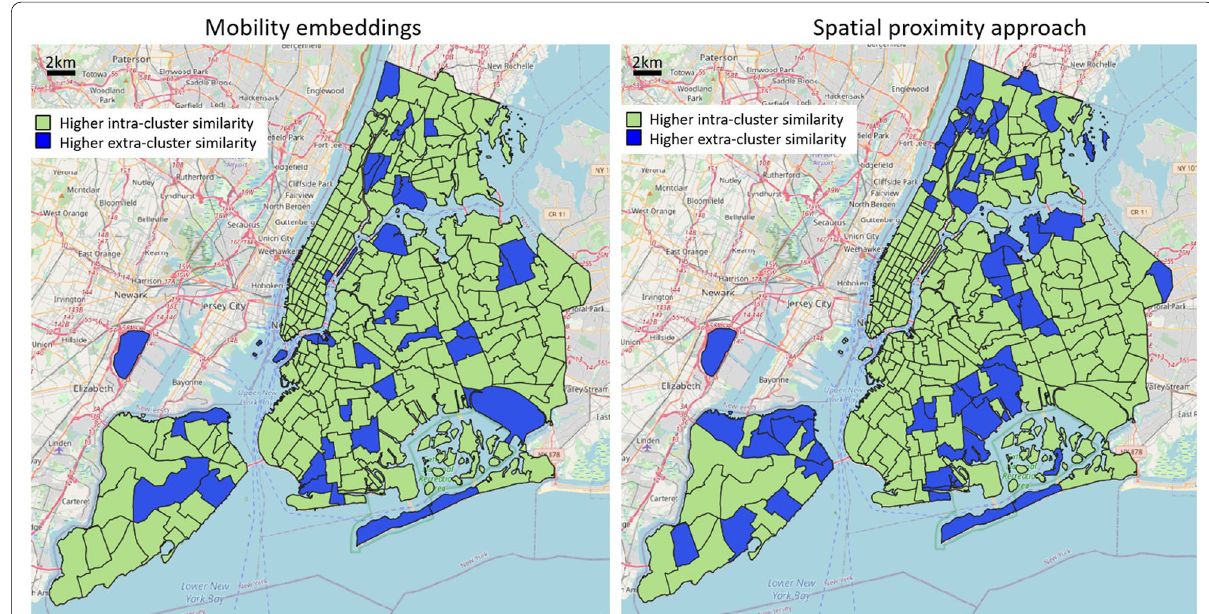
Fig. 8 Assessment of functionality cluster consistency according to different dining-related POI classes (fast food, restaurant, pub, café). Results are reported in terms of “winning” or “losing” similarity scores for each reference area